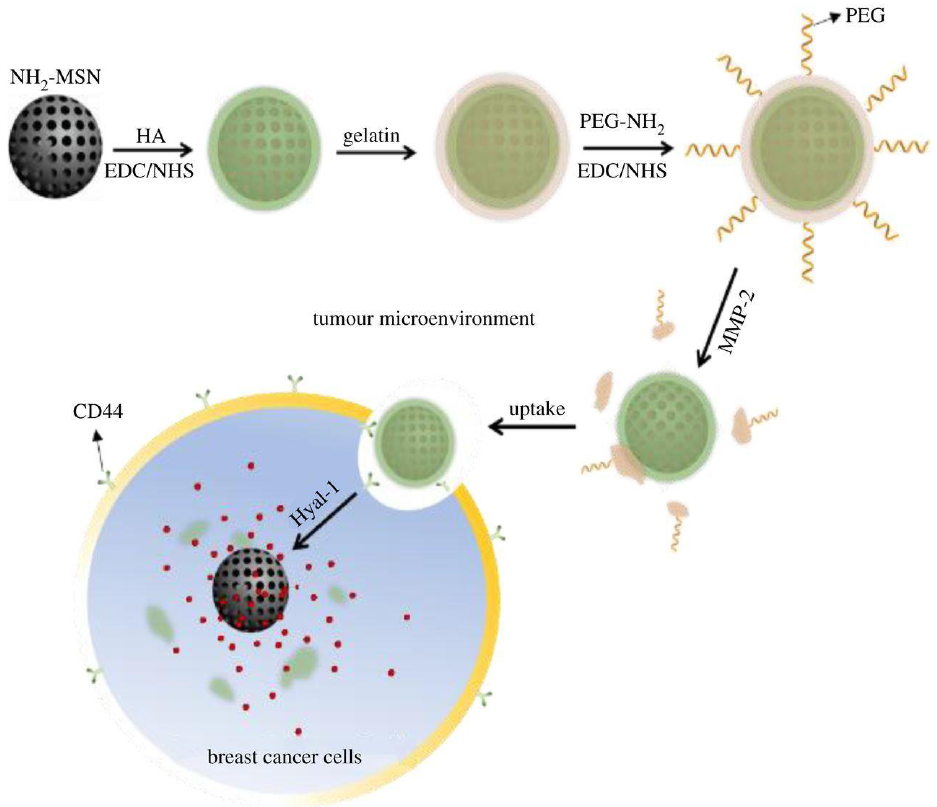
Figure 11. Schematic illustration of the formation of multifunctional drug-loaded MHGP and bienzyme-responsive tumor targeting and controlled release. Reproduced with permission from ref. [156] under the Creative Commons attribution (CC-BY) License.